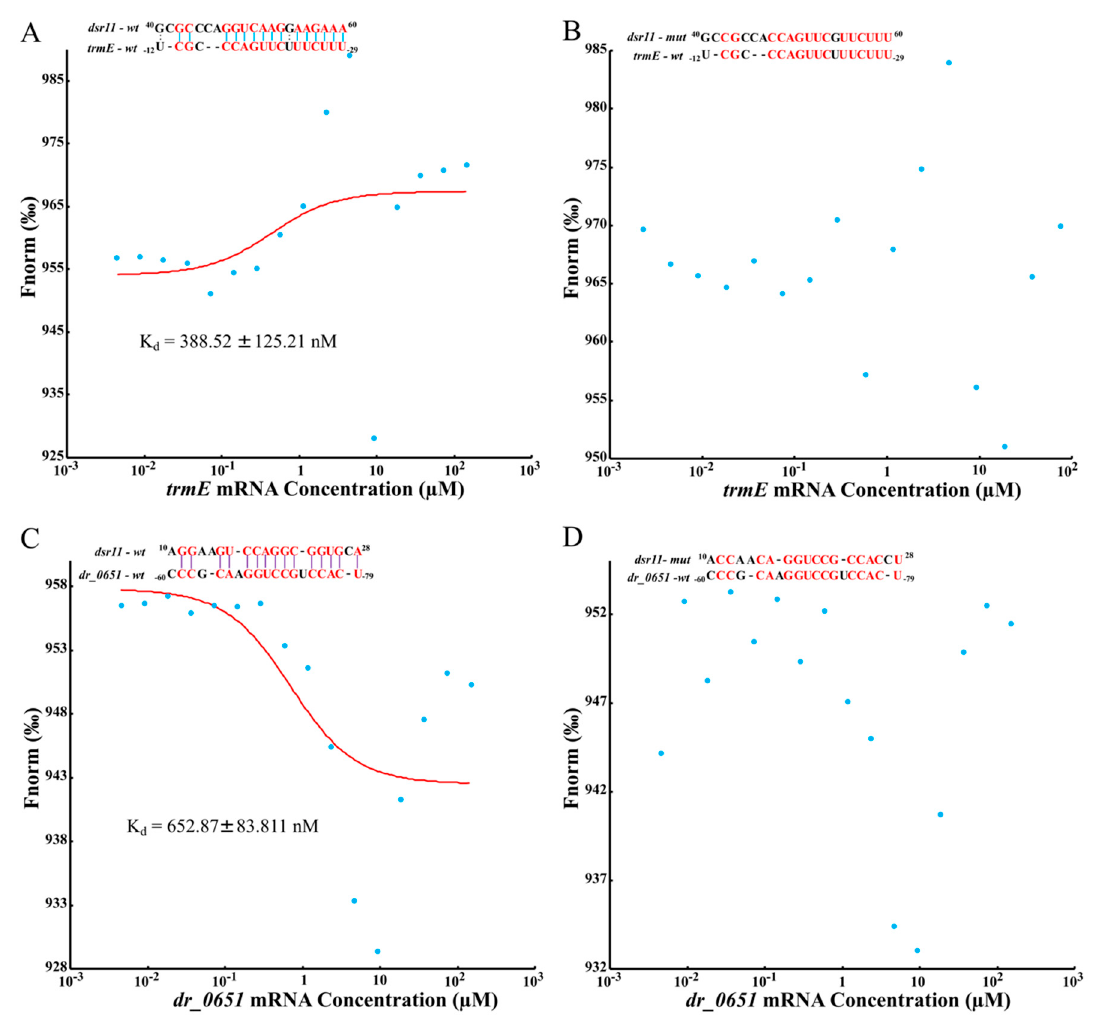
Figure 6. Determination of the binding affinity of dsr11 to target mRNAs by microscale thermophoresis (MST). Red bases mean complementary bases in the binding sequence, the red curve is the fitted combination curve, and the Kd (dissociation equilibrium constant) value is the binding constant of dsr11 and their targets. ( A , C ) are the binding of trmE mRNA and dr_0651 mRNA, respectively, with dsr11-wt . ( B , D ) are the binding of trmE mRNA and dr_0651 mRNA, respectively, with dsr11-mut .